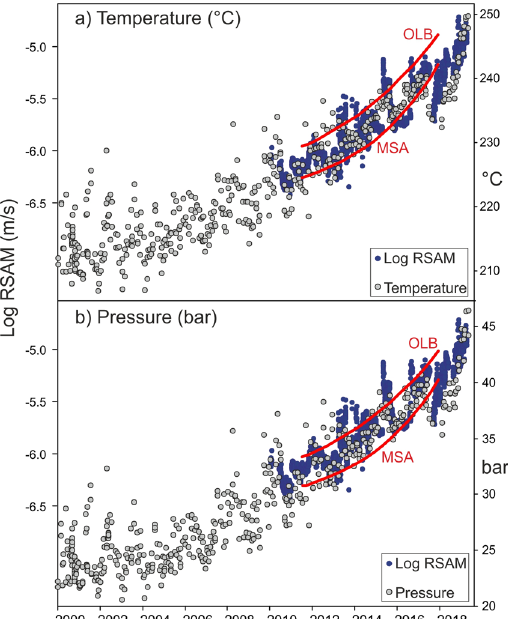
Figure 5. Comparison of temperature and pressure with radon trends and RSAM. Temperature ( a ) and pressure ( b ) hydrothermal system estimated by applying a gas-equilibria approach applied to the hottest fumaroles of Campi Flegrei. See refs. 45,50 for further details on the computations. The T-P estimates are compared with the log RSAM at CPIS 41,50 . The 222 Rn trends returned by EMD for OLB and MSA are also reported with the red line (see Fig. 3a for the